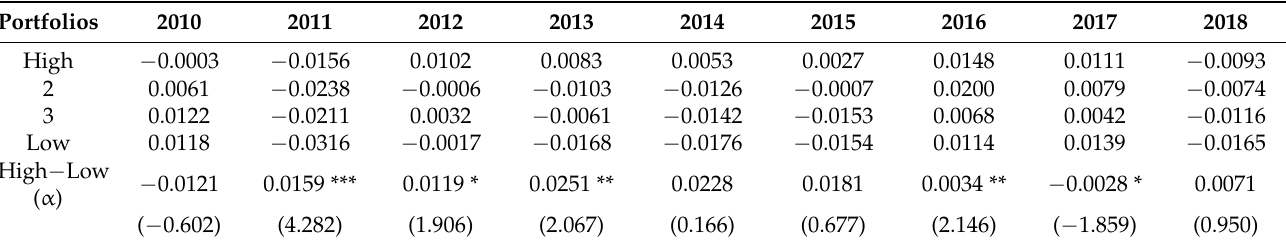
Table 4. Portfolio